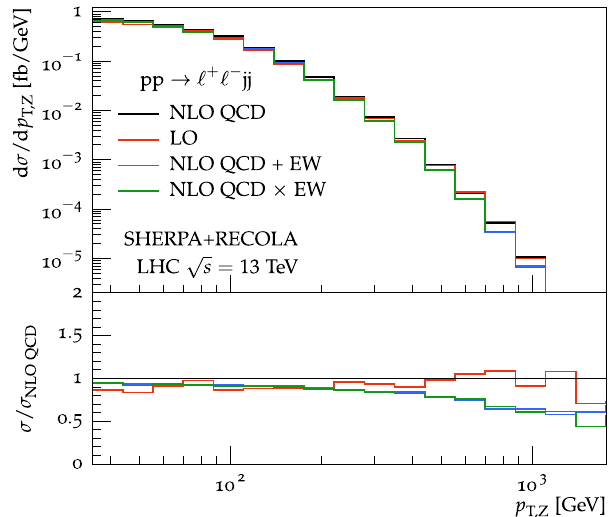
for off-shell Z production. The lower panels display the ratio of the distributions to the NLO QCD result